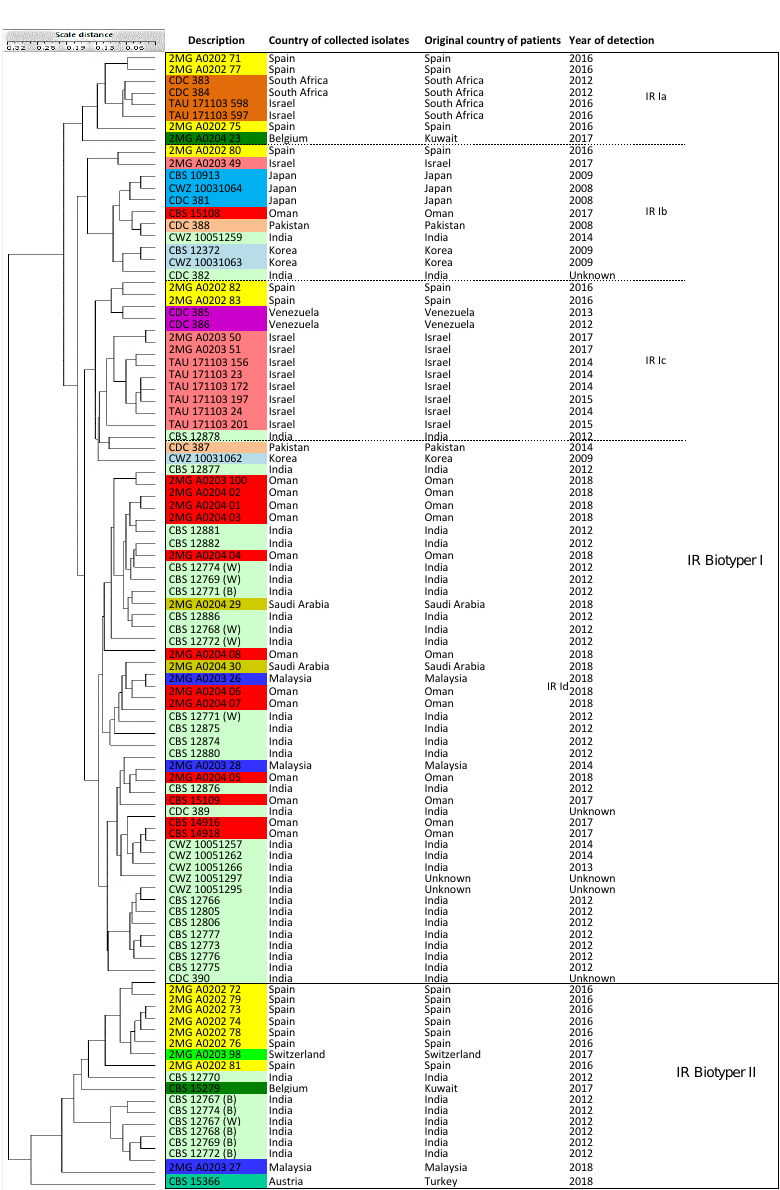
Figure 5. A UPGMA dendrogram generated with BioloMICS v12 of spectra generated by IR Biotyper. Two major clusters were created, namely, IR I and IR II, and among them, cluster IR I was divided into four sub-clusters, IR Ia-Id. IR Biotyper abbreviation (IR) was used for sub-clusters. The colur coding used for this dendrogram was the same as Figure